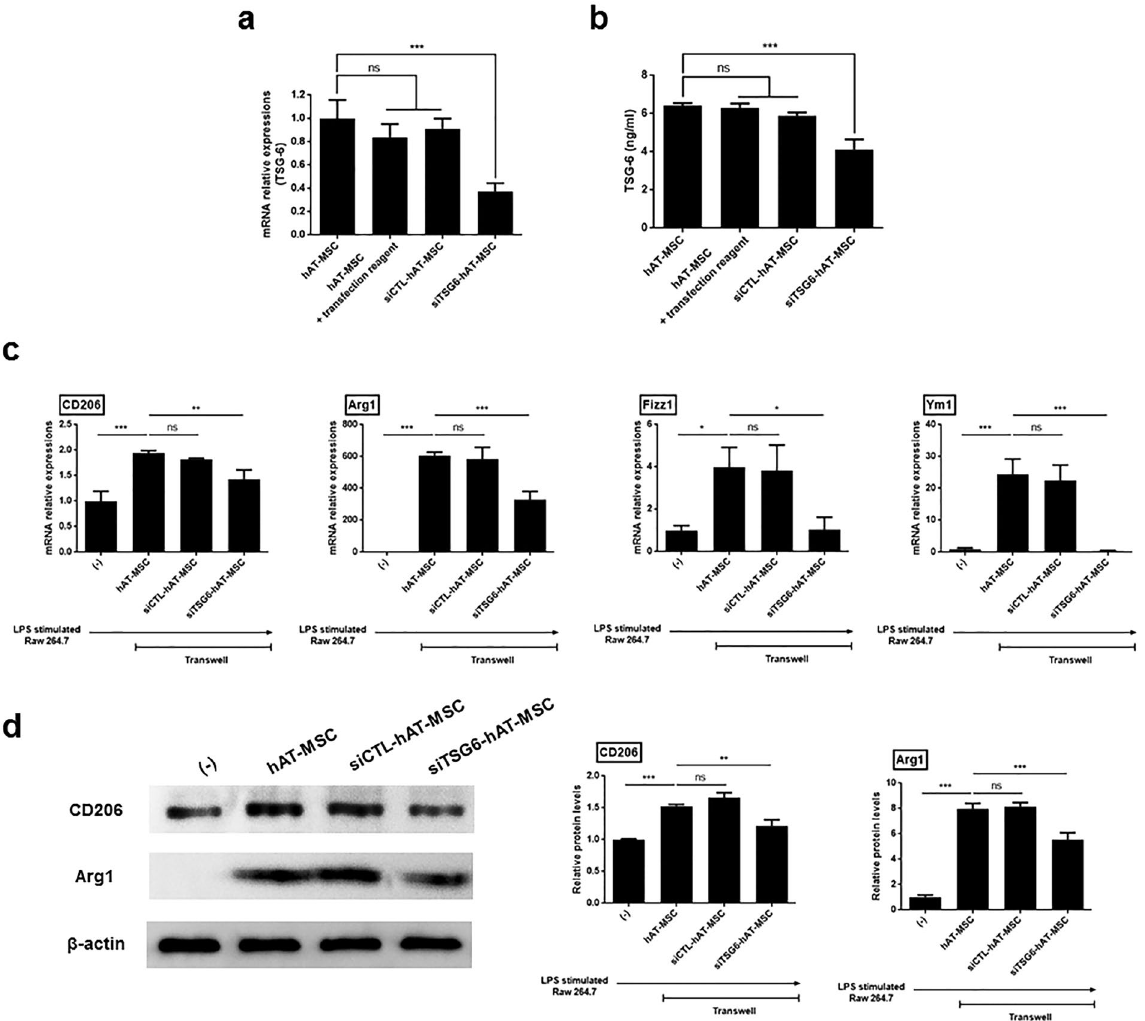
Figure 6. Expression of M2 macrophage markers decreases in hAT-MSCs transfected with TSG-6 siRNA. ( a , b ) TSG-6 (a) mRNA and ( b ) protein expression levels in hAT-MSCs transfected with TSG-6 siRNA (siTSG6-hAT- MSCs), hAT-MSCs transfected with control siRNA (siCTL-hAT-MSCs), hAT-MSCs with transfection reagent, and naïve hAT-MSCs. ( c , d ) LPS-stimulated Raw 264.7 macrophages were co-cultured with naïve or siCTL- or siTSG6-hAT-MSCs for 48 h. (c) CD206, Arg1, Fizz1, and Ym1 mRNA expression levels in these cells. ( d ) CD206 and Arg1 protein expression levels. Results are presented as mean ± standard deviation obtained in three independent experiments. * P < 0.05, ** P < 0.01, *** P <